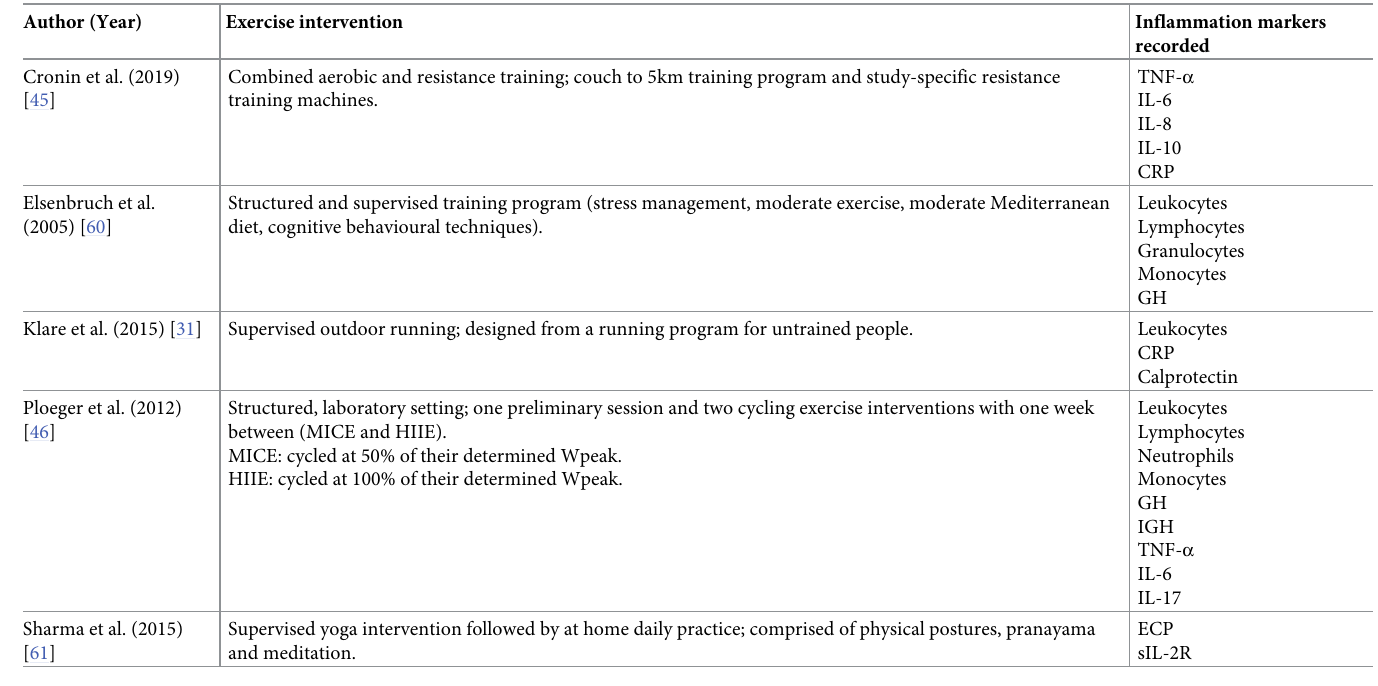
Table 1. Exercise intervention included and inflammatory markers investigated with their corresponding